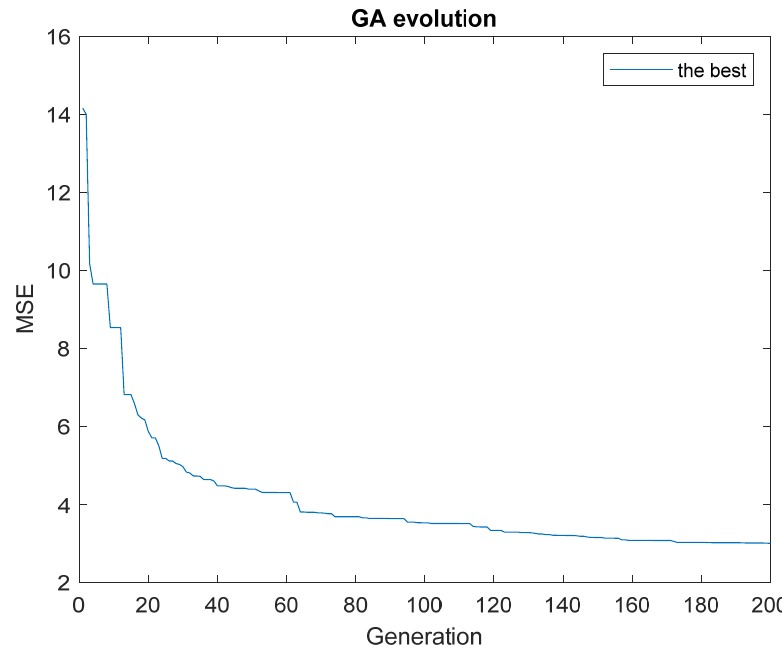
Figure 6. Evolution trajectory obtained by the GA specified, executed, and accelerated for the optimization of the k-Means-clustering-hybridized neuro-fuzzy classifier in this experiment. The GA was configured in terms of (population size, crossover fraction, mutation rate) at (350, 0.75, 0.01). The GA determined the fitness value, MSE, where the lower the error, the higher the fitness.